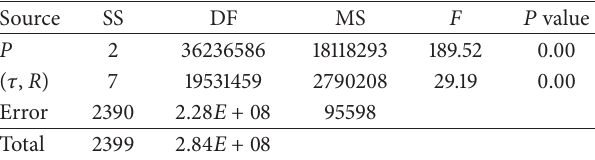
Table 2: ANOVA table for the number of nodes with 𝑛 = 12 and 𝜃 = 0.5 .